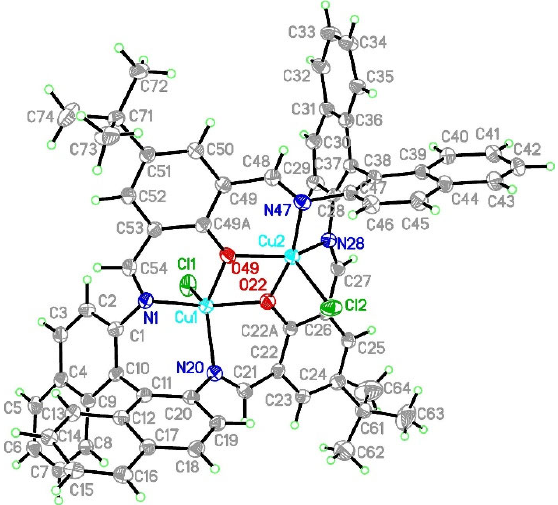
Figure 4. Structure of [Cu 2 Cl 2 (L)] ∙ H 2 O K2 with a numbering scheme and thermal ellipsoids at 30% probability.